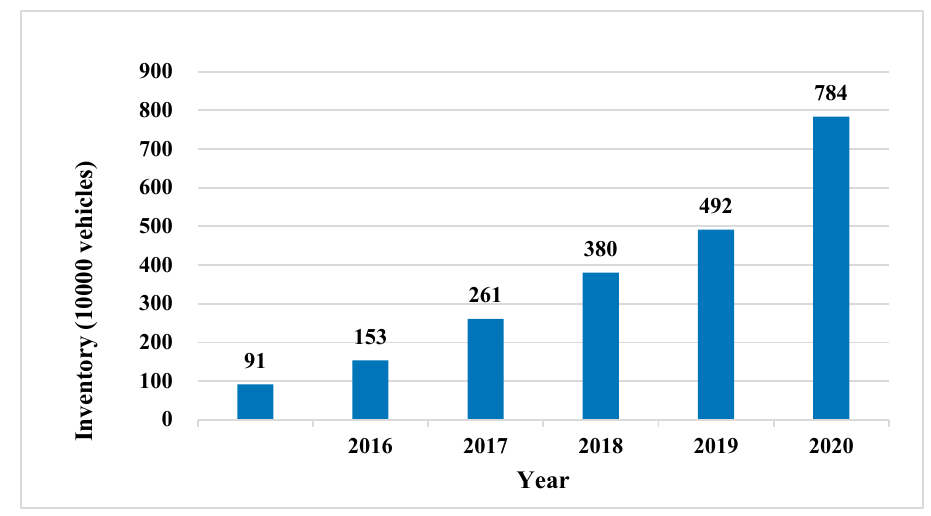
Figure 1. Statistics on the number of new energy vehicles in China from 2016 to 2021